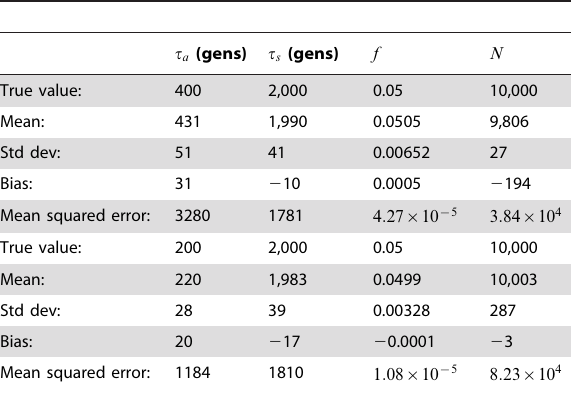
Table 1. Inferring the parameters of a simple admixture scenario.